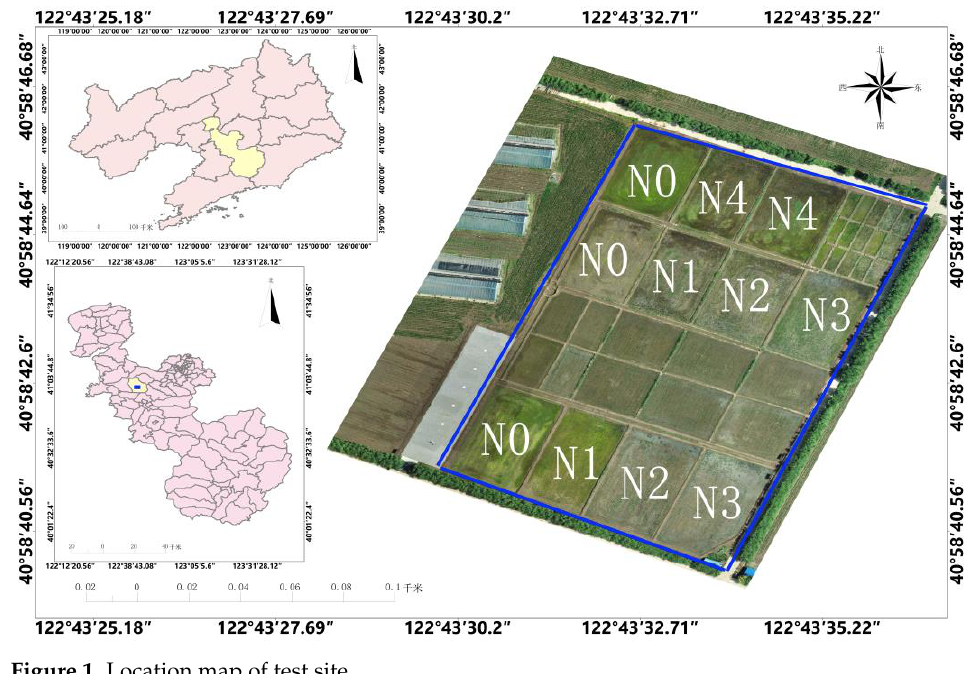
Figure 1. Location map of test site. Table 1. The key test time nodes.